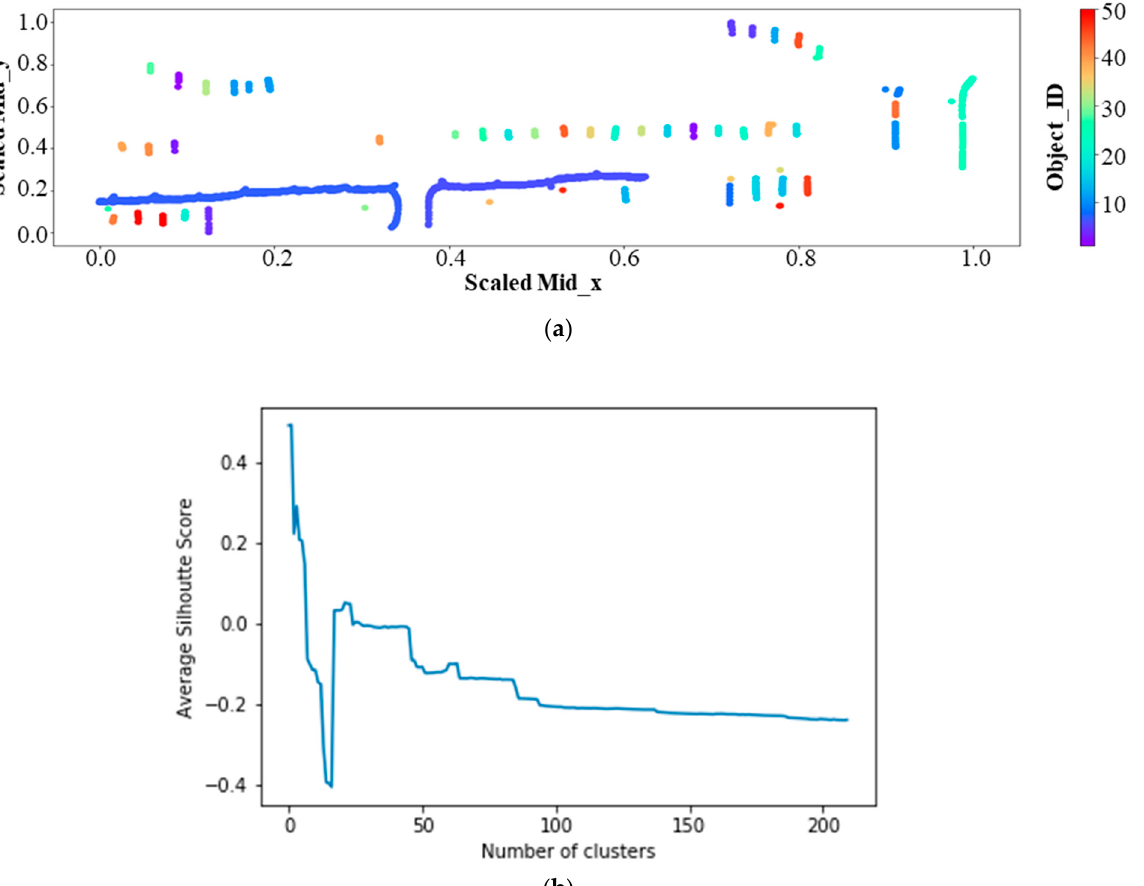
Figure 9. Post-processing result for silt fence segments. ( a ) Silt fence clustering result-18 July 2019; ( b ) silhouette score plot.